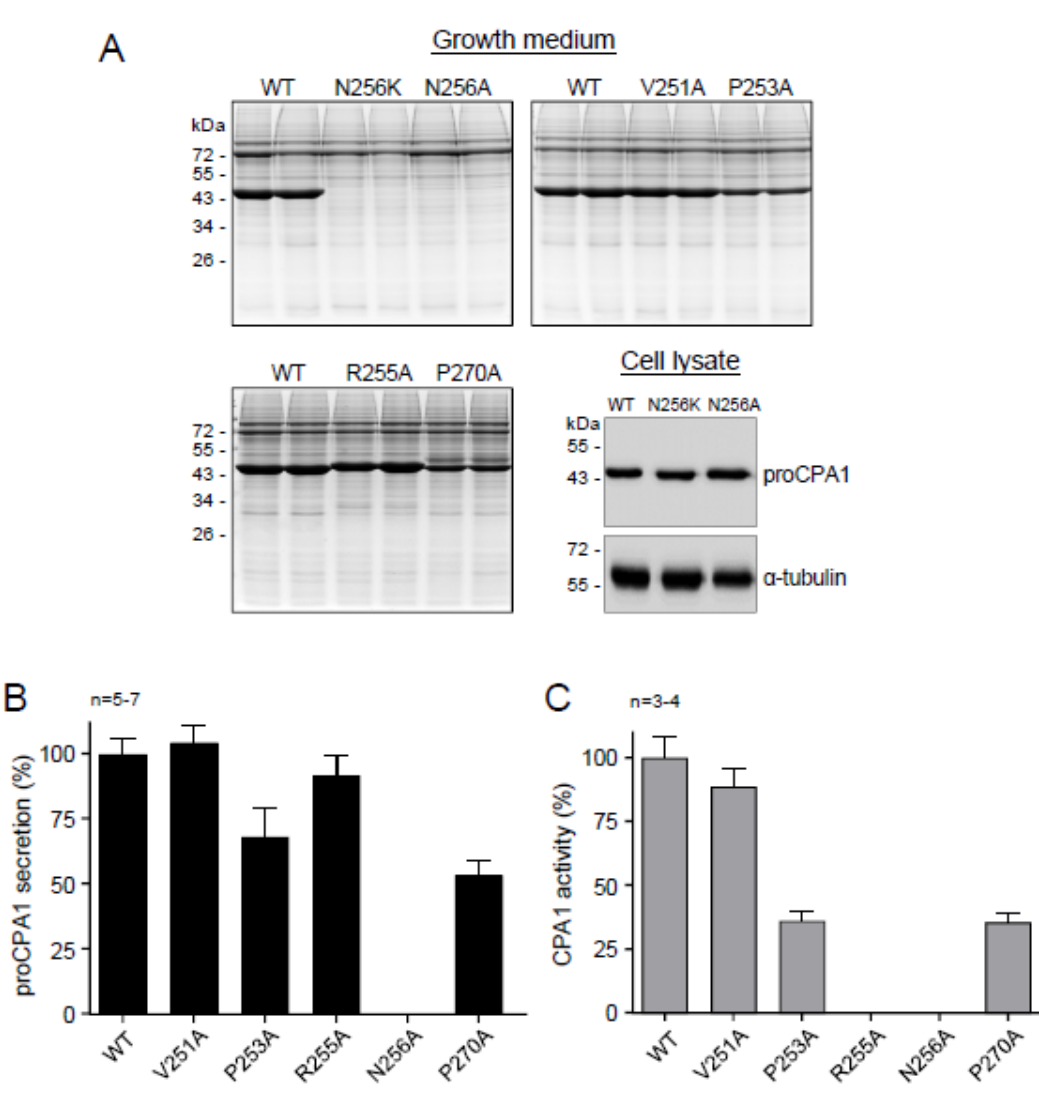
Figure 6. Effect of CPA1 Ala-variants on cellular secretion and enzyme activity. Secretion of proCPA1 protein from transfected HEK 293T cells was assessed by SDS-PAGE and Coomassie Blue staining. Protein levels of the p.N256A variant in cell lysates were analyzed by Western blotting. Alpha-tubulin was measured as a loading control. ( A ) Effect of CPA1 variants p.V251A, p.P253A, p.R255A, p.N256A, and p.P270A. For comparison, variant p.N256K was also included. ( B ) Densitometric analysis